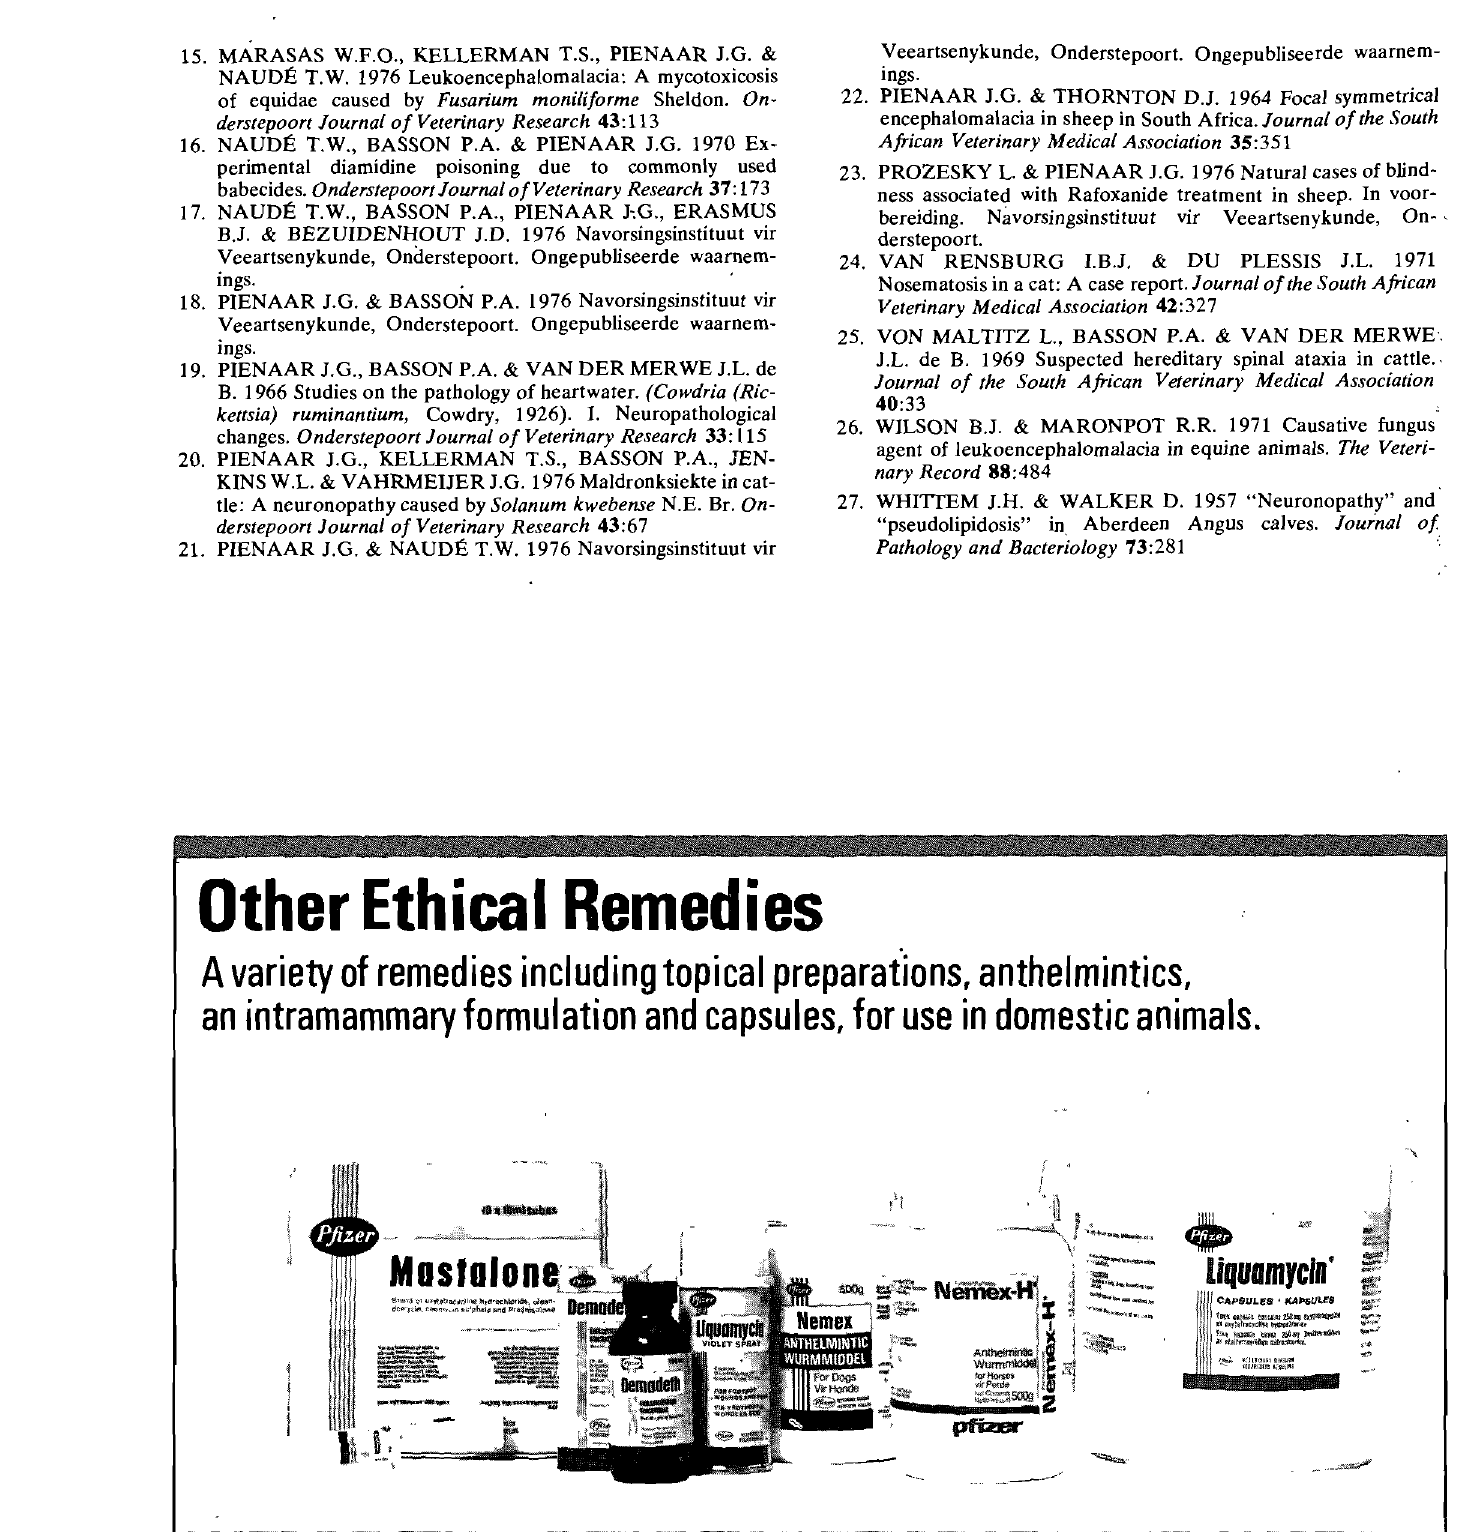
Eye/Ear 4 ml. Mastalone 10 x 10 ml. Demadeth 1 DO